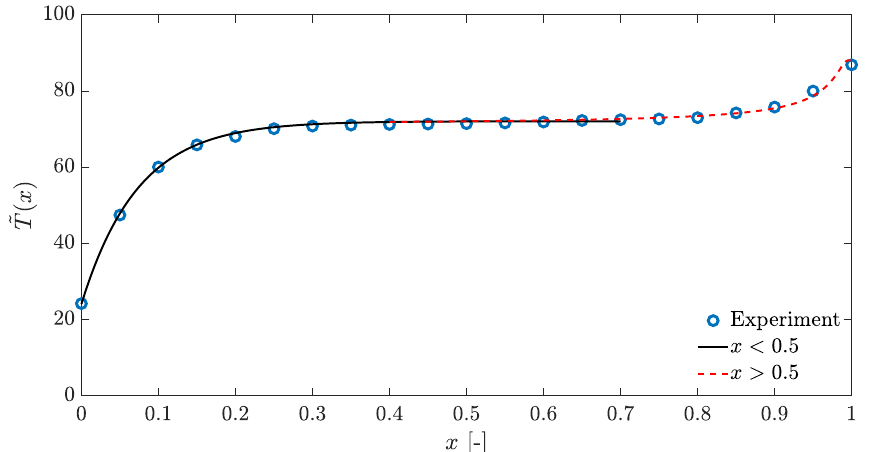
Figure 9. Transition temperature as a function of the austenite volume fraction, measured at equi- librium under a constant stress of 20 MPa. The curved lines represent a fit to Equation (20a,b) with